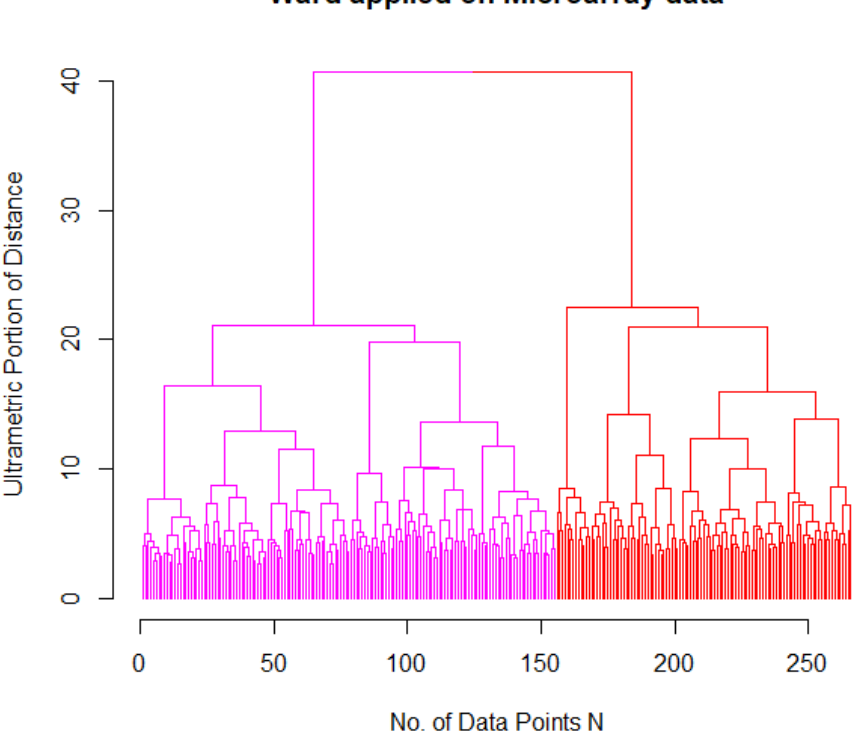
Figure 2. Dendrogram of Ward clustering applied to microarray np-AML patient samples revealed two subgroups (magenta and red). Clustering and dendrogram generation were computed with the R package “FCPS”, available on CRAN. The dataset provided normal controls in addition to APL. Both diagnostic entities were not used in the clustering.